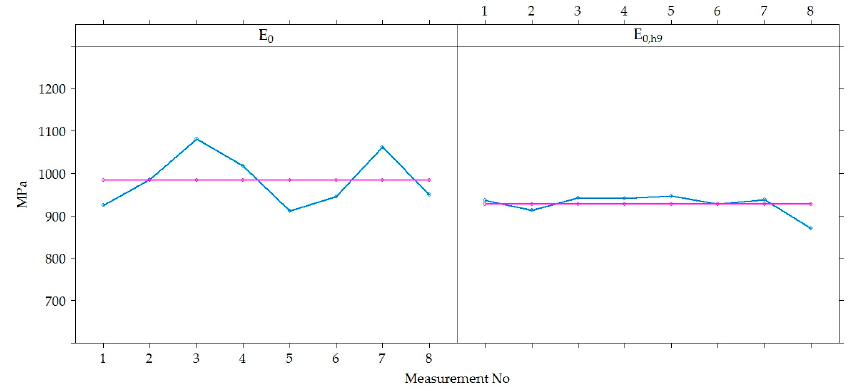
Figure 14. E 0 and E 0,h9 mean values and their fluctuations regarding the total average over time.